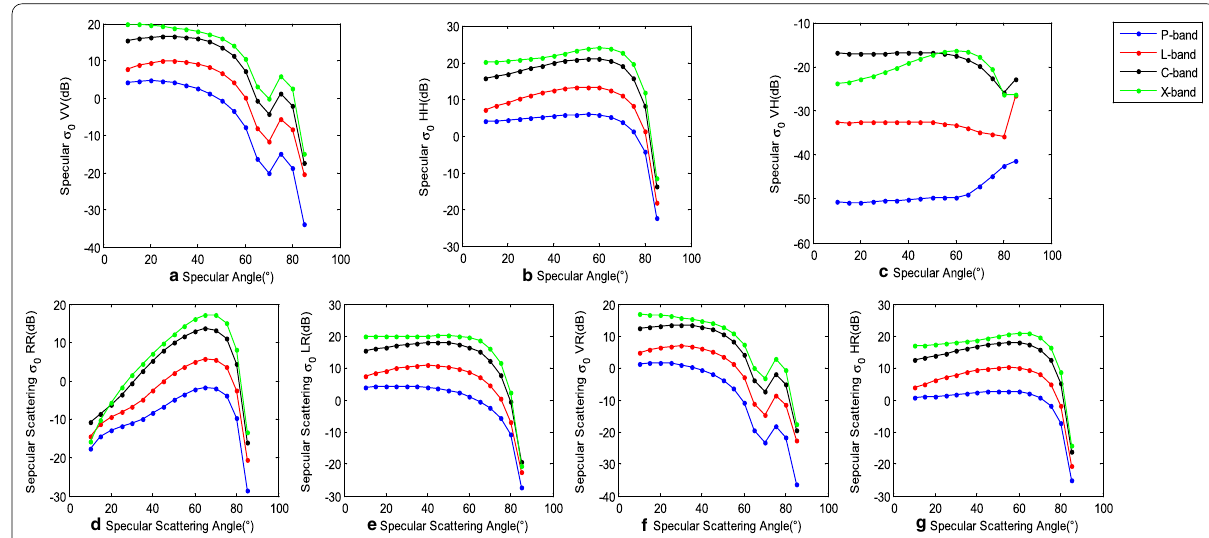
Fig. 12 Canopy scattering cross section versus scattering angle from aspen for L-, C-, and X-bands at specular